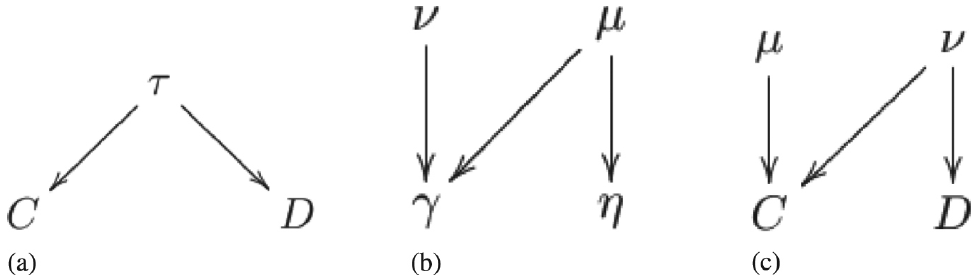
Figure 5: Example of how to reduce a causal model with a latent trit to one involving only latent bits. (a) The original 1 )  mod 2 . (b) the trit u is replaced by two causal model, with functional dependences u = u mod 2 , and u =  2 (u ⊕ 3 bits, u and u , which are presumed to be determined by a causal model having the depicted causal structure with func- tional dependences u = uu , and u = u . (c) The causal model with binary latents that simulates the original model; the u , and u = u functional dependences are u = uu ⊕ 2